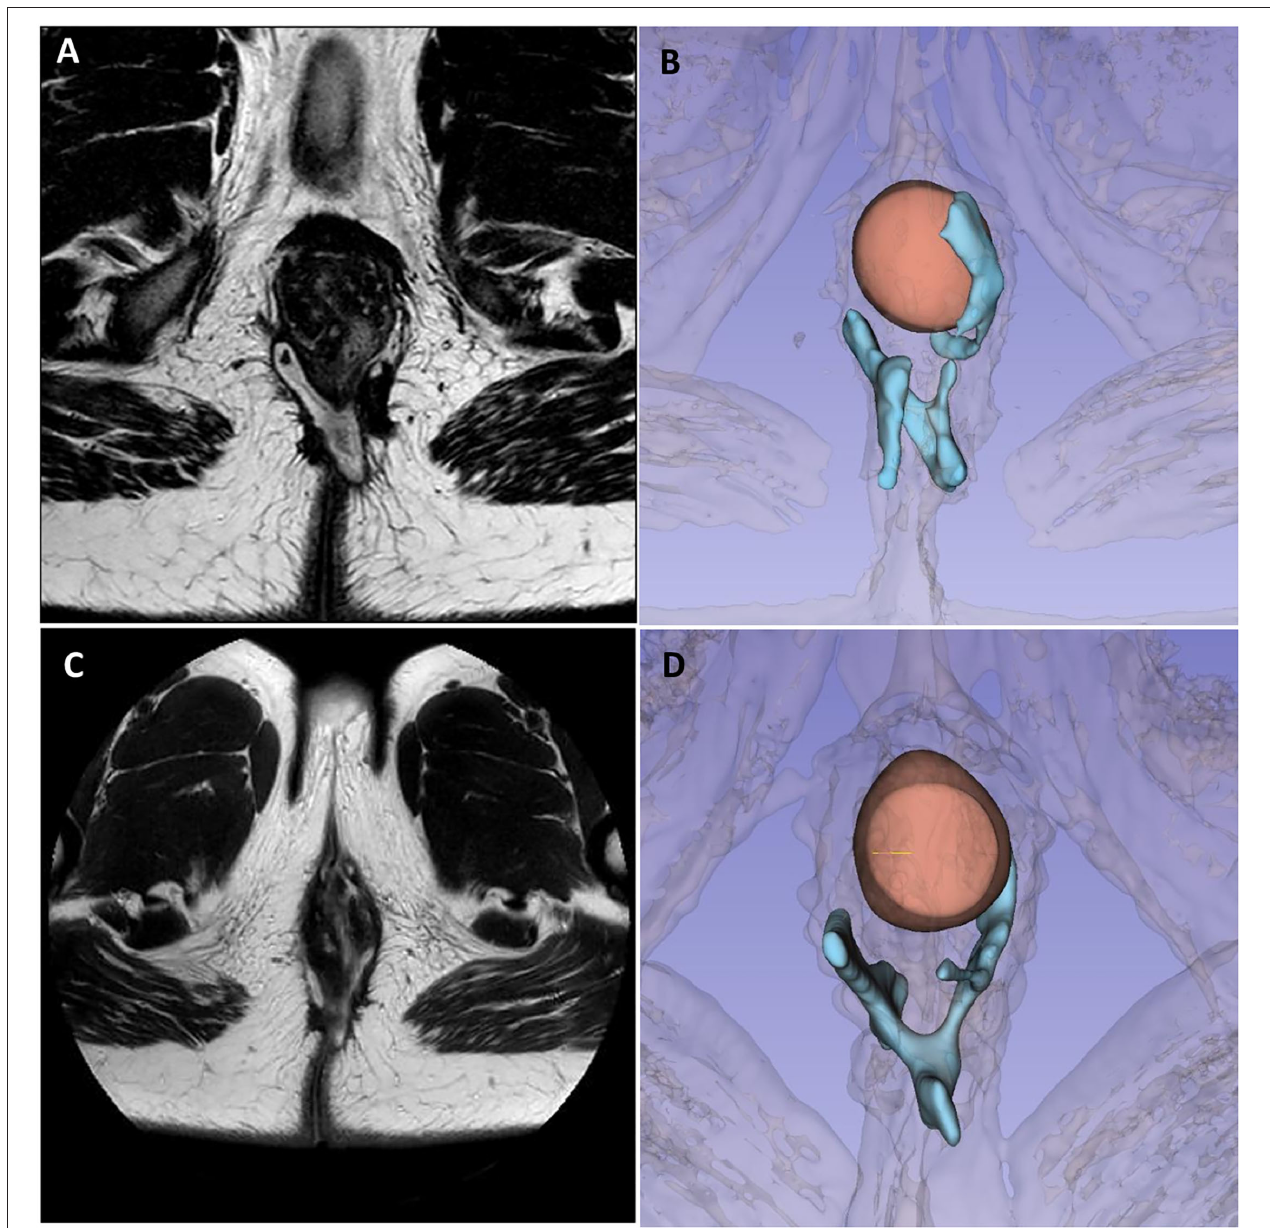
FIGURE 2 | Case 1 imaging pre- and post-surgery. Panels (A, B) show preoperative pelvic magnetic resonance imaging and 3D reconstruction highlighting a complex branched perianal fistulising disease with trans-sphincteric fistulas joining in the posterior plane with two external orifices on the right and one on the left, with a 2-cm abscess in the left ischioanal fat. Panels (C, D) show 6-month MRI follow-up, with the persistence of fistula tracts, less signs of inflammation, less thickening, contrast enhancement, and no fluid